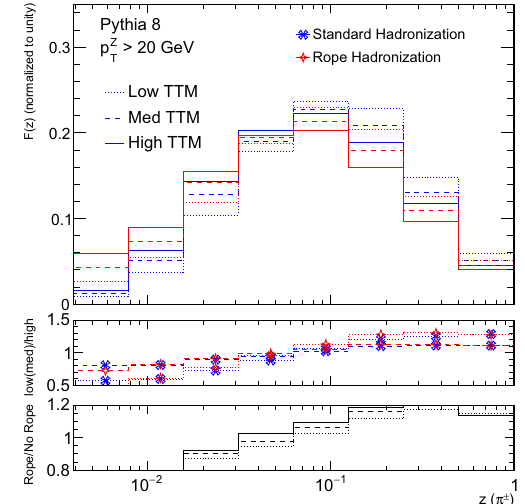
Fig. 13 The average mass (left) and z g (right) as a function of the FM multiplicity and various models of collective effects. Higher multiplicities are to the left